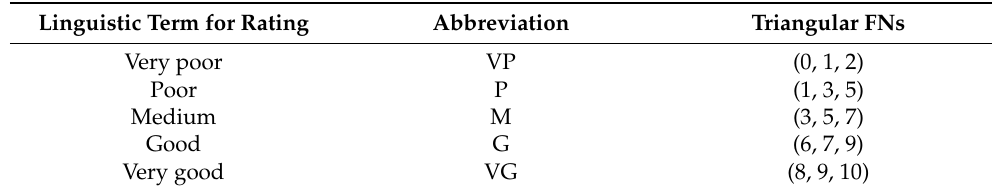
Table 1. Linguistic scale to evaluate the performance of